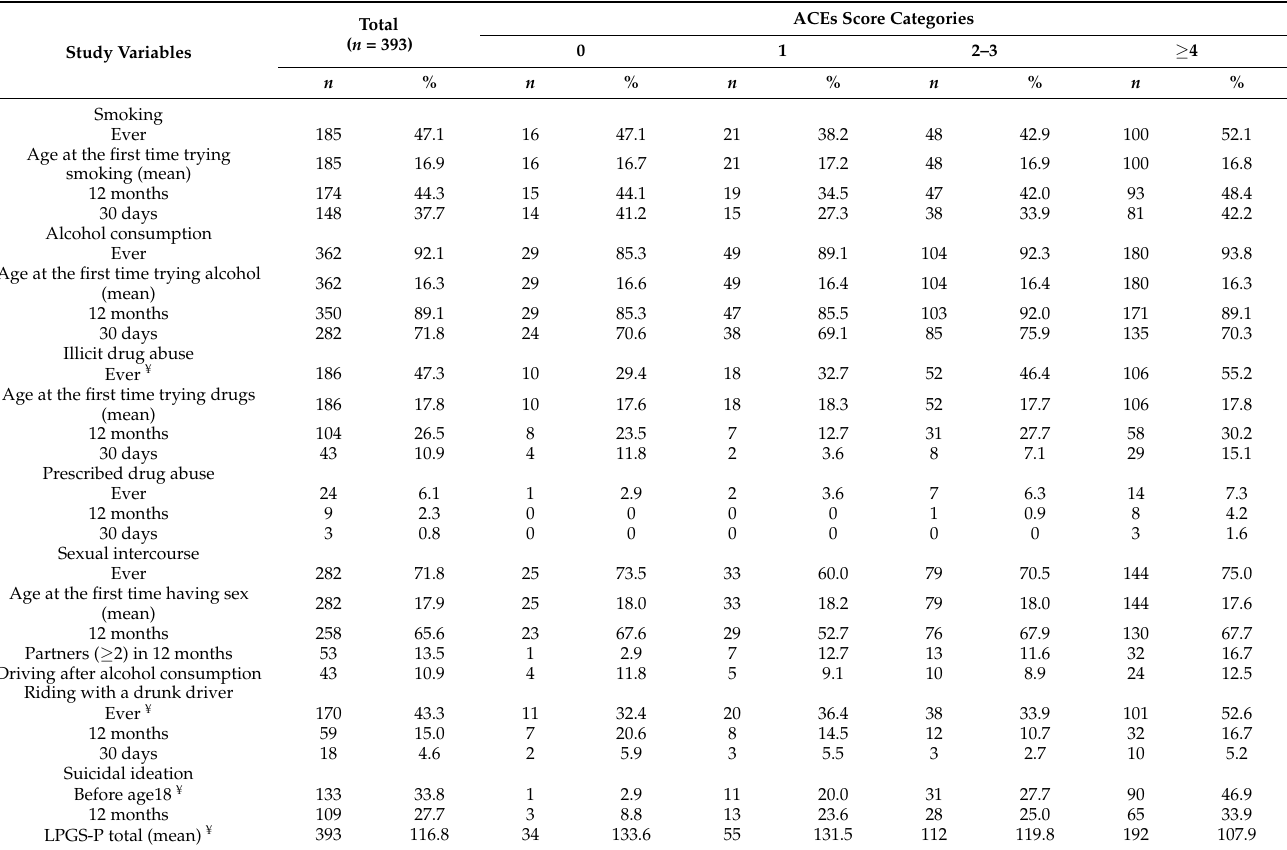
Table 2. Health risk behaviour outcomes and psychological well-being scores in the study sample ( n = 393) and in four categories of exposure of adverse childhood experiences